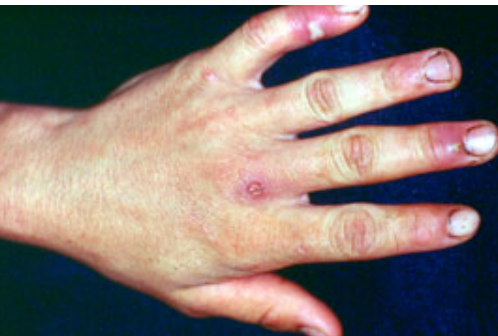
Figure 10: Multiple violaceous erythematous lesions, some of them are umbilicated.